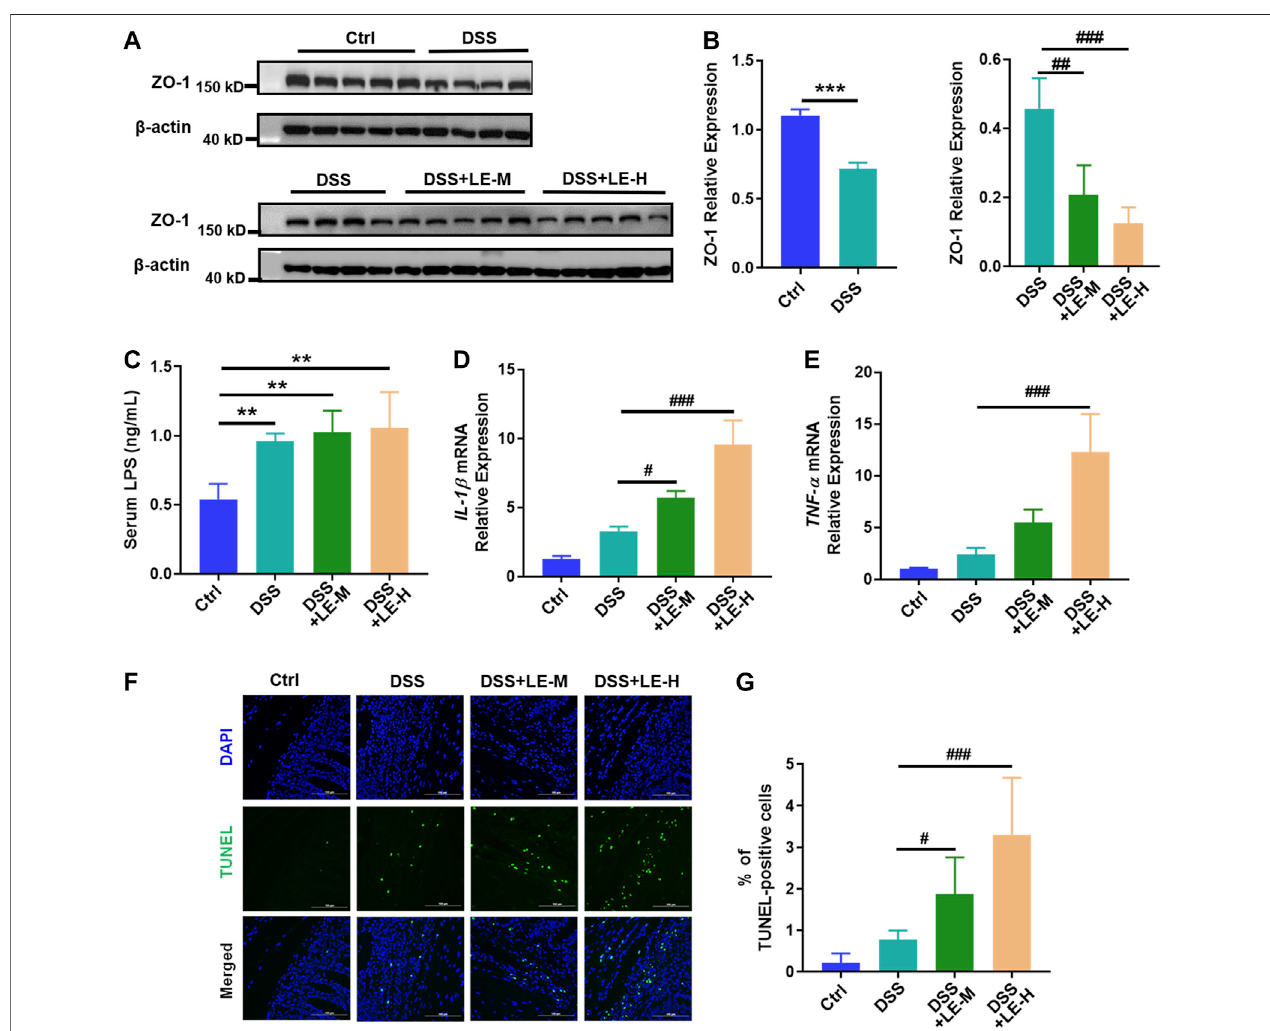
FIGURE 5 | Excessive intake of longan extract (LE) increases gut permeability and enhances colonic injury in colitic mice. (A) Protein expression of ZO-1 in colon tissues ( n (cid:1) 4 – 5). Antibody for β -actin was used as internal control. (B) Relative expression of ZO-1 over β -actin via gray analysis by ImageJ. (C) Serum LPS level ( n (cid:1) 4). (D) Foldchangeof IL-1 β mRNAlevelincolontissue( n (cid:1) 4). (E) Foldchangeof TNF- α mRNAlevelincolontissue( n (cid:1) 4). (F) TUNELstainingofcolontissue(allpicturesata × 400 magni fi cation) ( n (cid:1) 3). (G) Number of TUNEL-positive cells. Ctrl, control mice; DSS, 3.5% DSS-treated mice; DSS + LE-M, 3.5% DSS-treated mice supplemented with medium-dose LE (8 g/kg); DSS + LE-H, 3.5% DSS-treated mice supplemented with high-dose LE (16 g/kg). Data are presented as mean ± SD. * p < 0.05, ** p < 0.01, *** p < 0.001, compared to Ctrl; # p < 0.05, ## p < 0.01, ### p < 0.001, compared to DSS